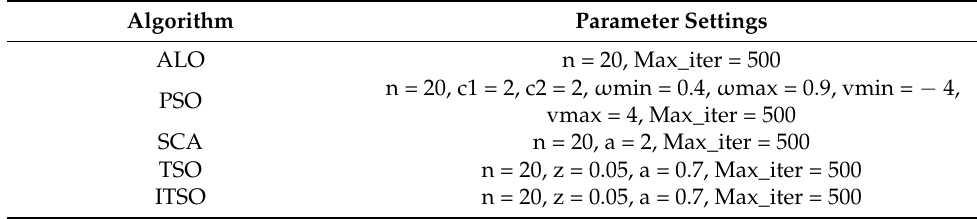
Table 1. Parameter settings for algorithms.